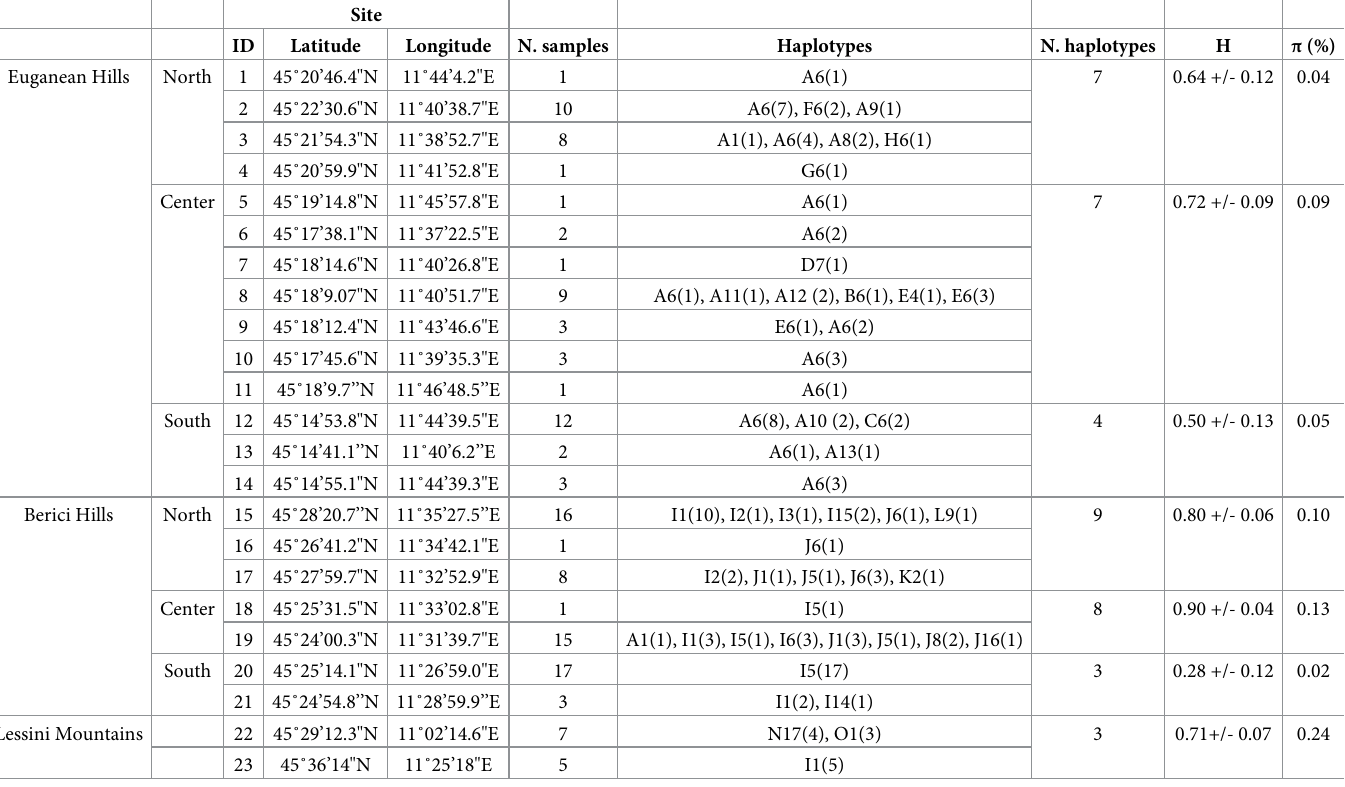
Table 1. Collection sites of B . vicetinus populations analysed and descriptive statistics of each